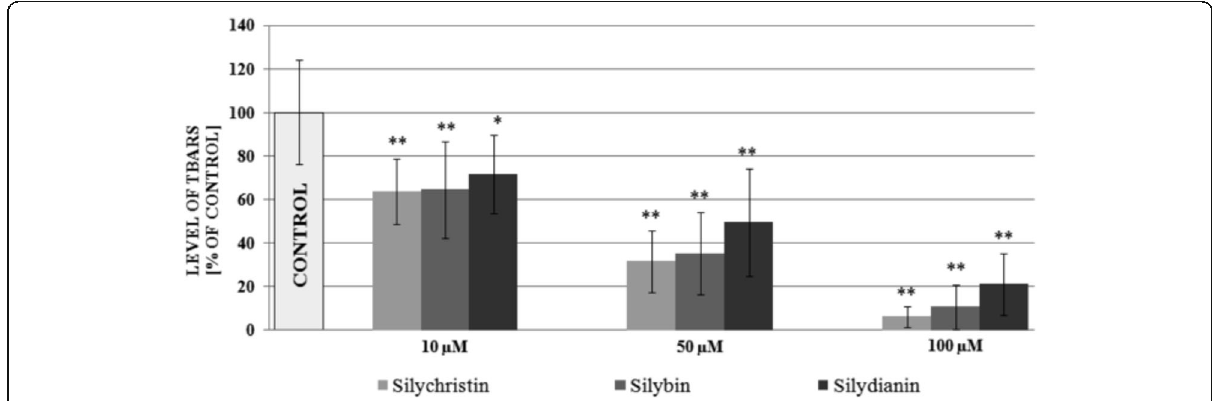
Fig. 3 The effect of flavonolignans (silychristin, silybin and silydianin at concentrations 10; 50 and 100 μ M) on the blood platelets COX metabolite pathway was estimated by the level of TBARS concentration measurement. The data represents means of ± SD, n = 12. Statistical analysis was performed using the Kruskal-Wallis test, * p < 0.05, ** p <